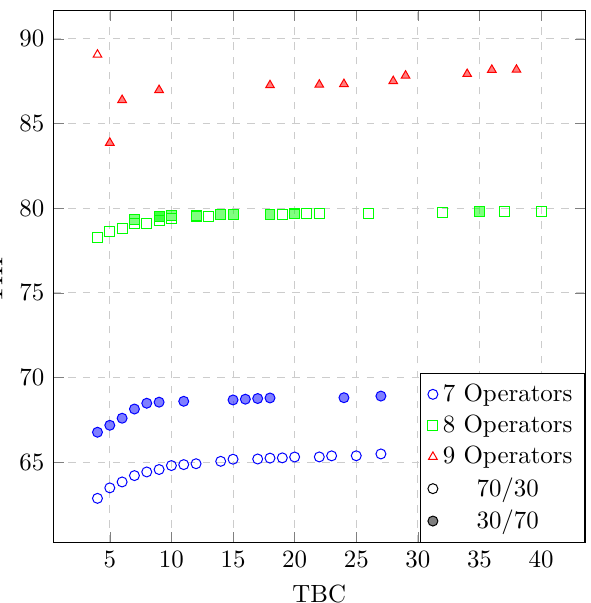
Figure 7. Objective space of the non-dominated solutions from all scenarios in the initial